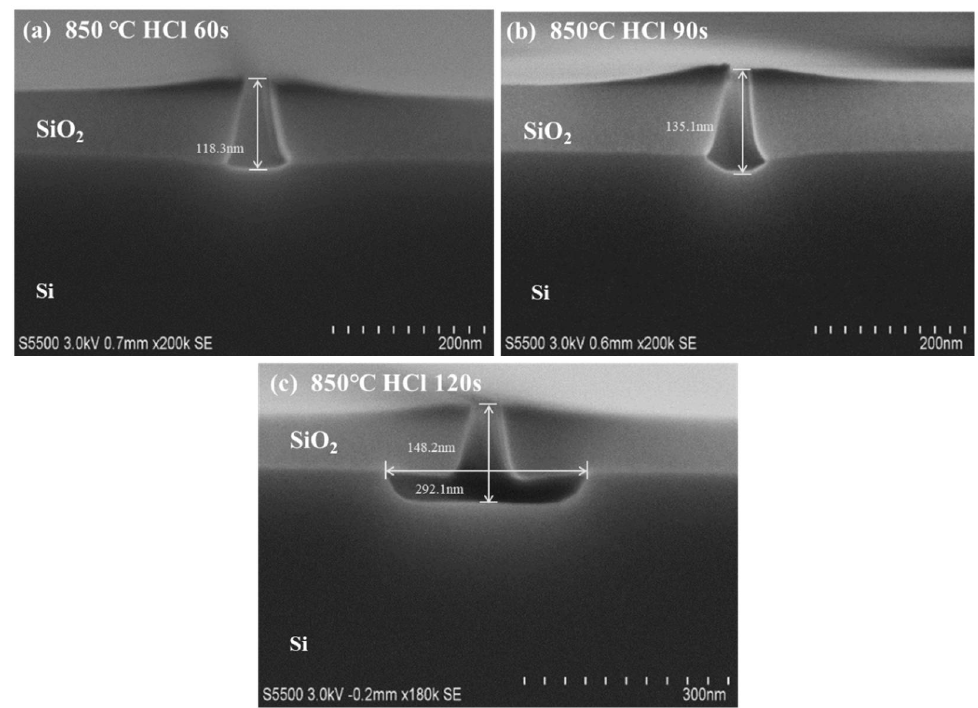
Figure 4 . Depth and morphology of in situ HCl dry etching under different experimental times at 850 ℃: ( a ) 60 s; ( b ) 90 s; ( c ) 120 s.